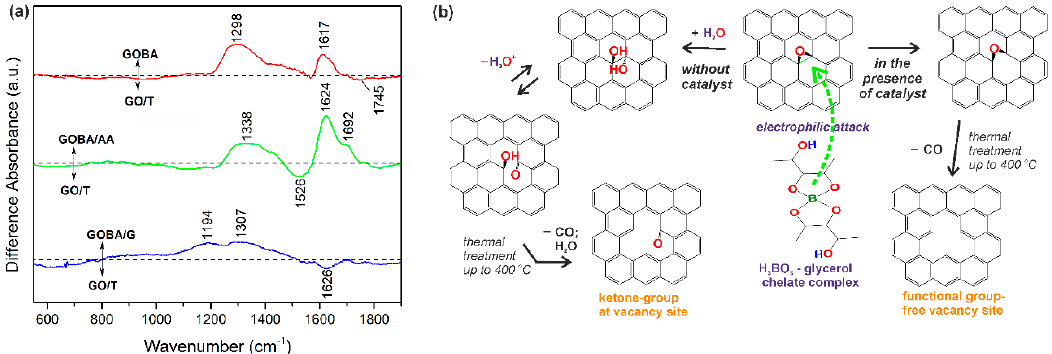
Figure 3. FTIR-difference spectra of mrGO samples. ( a ) Spectra are normalized according to absorbance of C=C stretching band of sp 2 hybridized carbon at 1568 cm − 1 ; ( b ) Scheme of GO reduction reactions occurring in the presence and absence of BA-glycerol chelate complex catalyst.